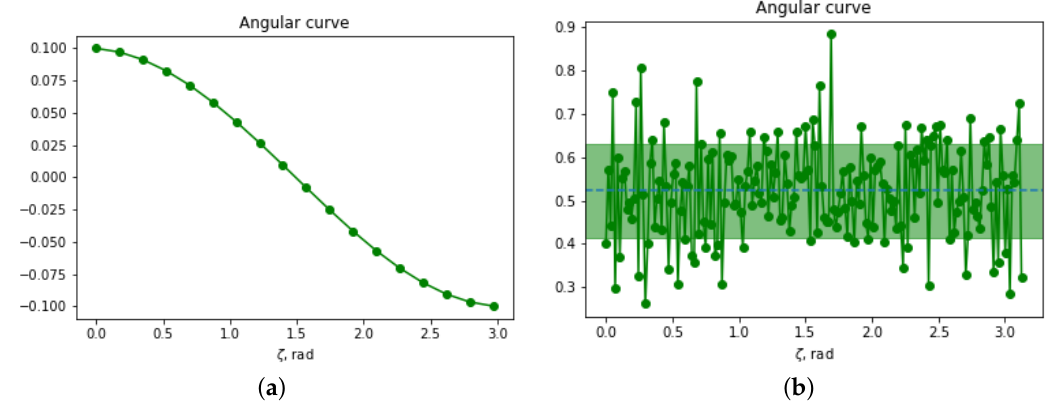
Figure 5. Angular curves for the ( a ) Long-wavelength background; ( b ) Short-wavelength background. The band shows 1 σ confidence interval for the constant value of F ( ζ ) .